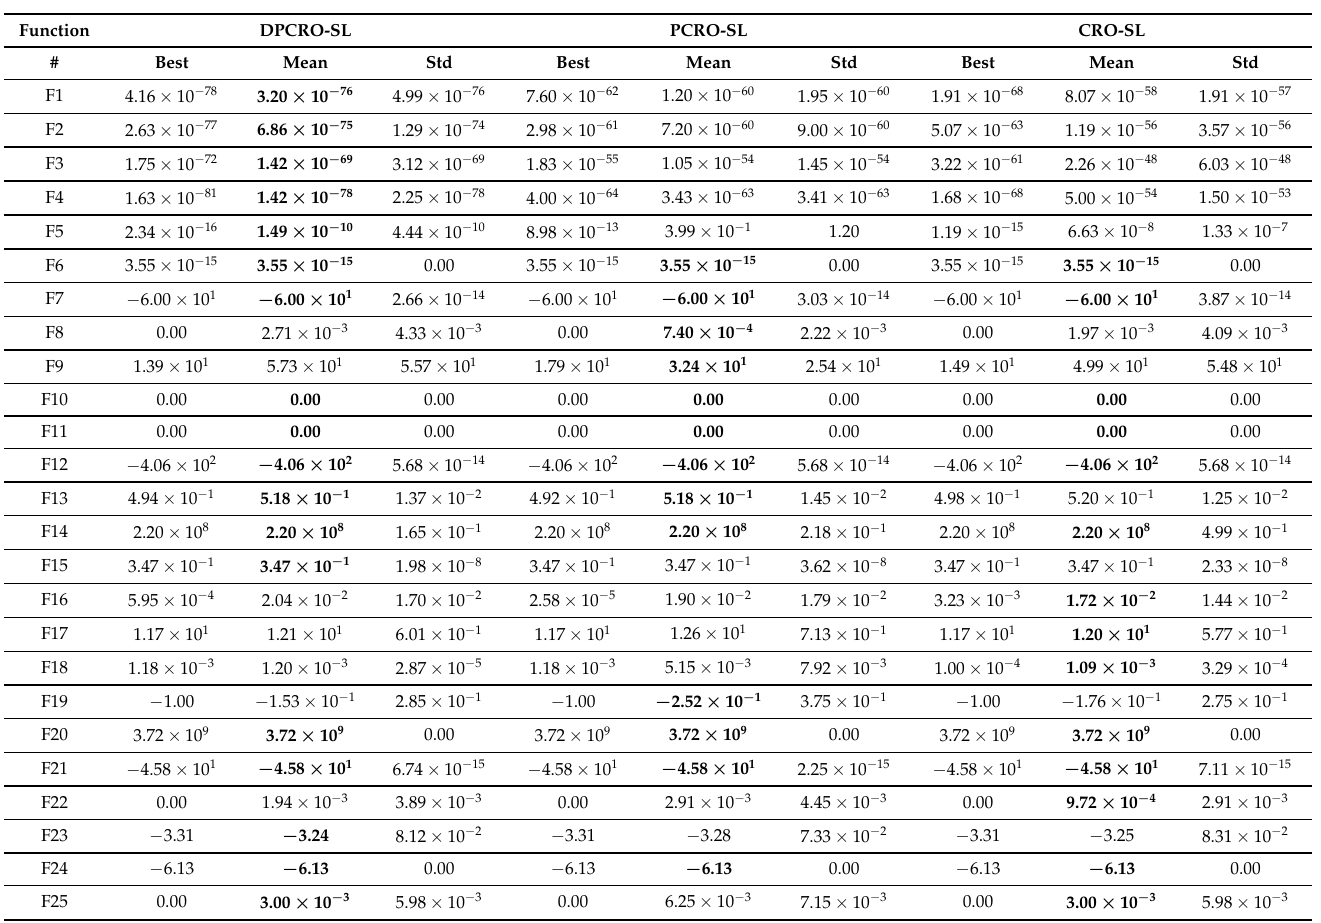
Table 1. Comparison among different CRO-SL ensemble variants (CRO-SL, PCRO-SL and DPCRO-SL) with 4 DE-based substrates. We indicate the best mean fitness for each CRO variant in bold